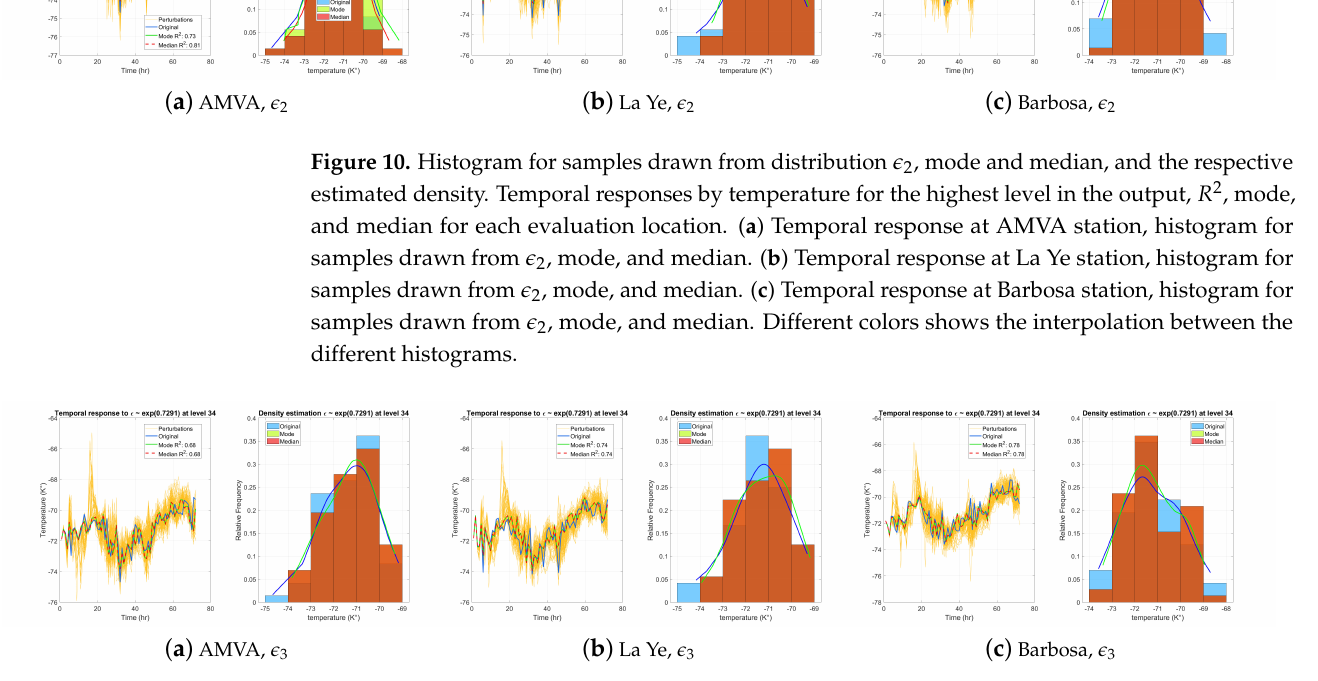
Figure 11. Histogram for samples drawn from distribution (cid:101) 3 , mode, and median, and the respective density estimated. Temporal responses by temperature for the highest level in the output, R 2 , mode, and median for each evaluation location. ( a ) Temporal response at AMVA station, histogram for samples drawn from (cid:101) 3 , mode, and median. ( b ) Temporal response at La Ye station, histogram for samples drawn from (cid:101) 3 , mode, and median. ( c ) Temporal response at Barbosa station, histogram for samples drawn from (cid:101) 3 , mode, and median. Different colors shows the interpolation between the different